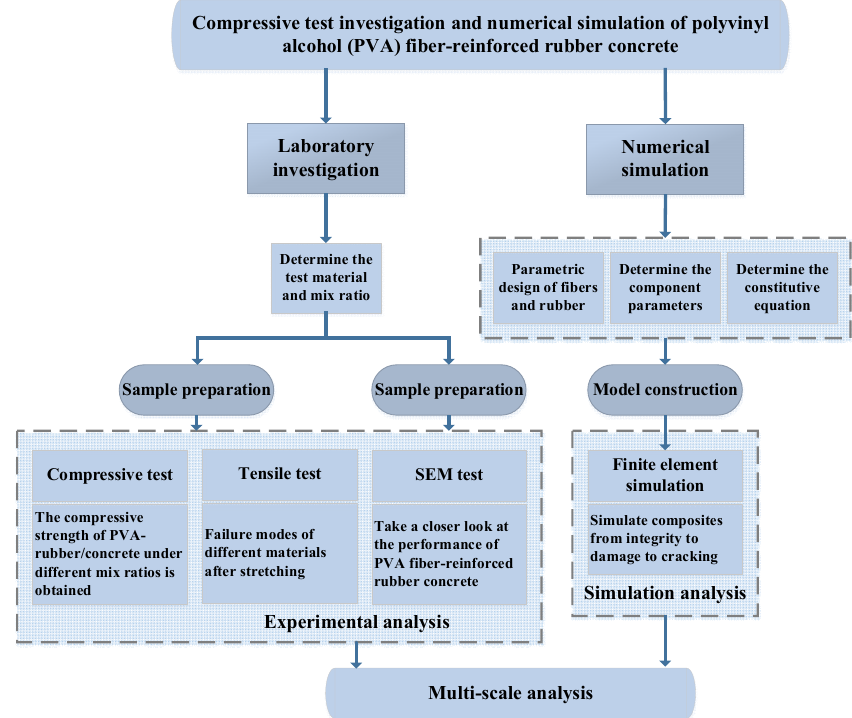
Figure 1. Technology